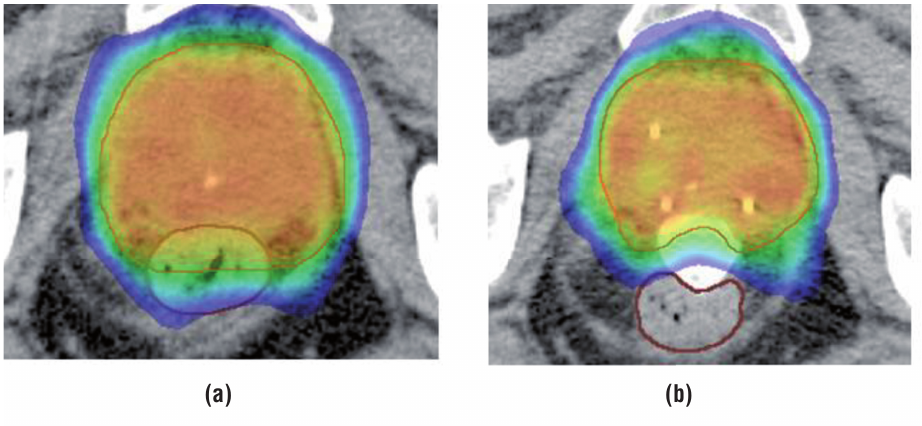
figure 2 - Isodose distribution in an axial cT plane before (a) and after rectum balloon implant (RBI) implantation (b) in the same patient. The image on the left shows the high-dose region >80% (green) overlapping the entire part of the rectum (brown), whereas with the RBI in situ the high-dose region is not in the rectum. The 65% isodose contour (blue) overlaps the entire rectum in (a), whereas there is no overlap in the rectum